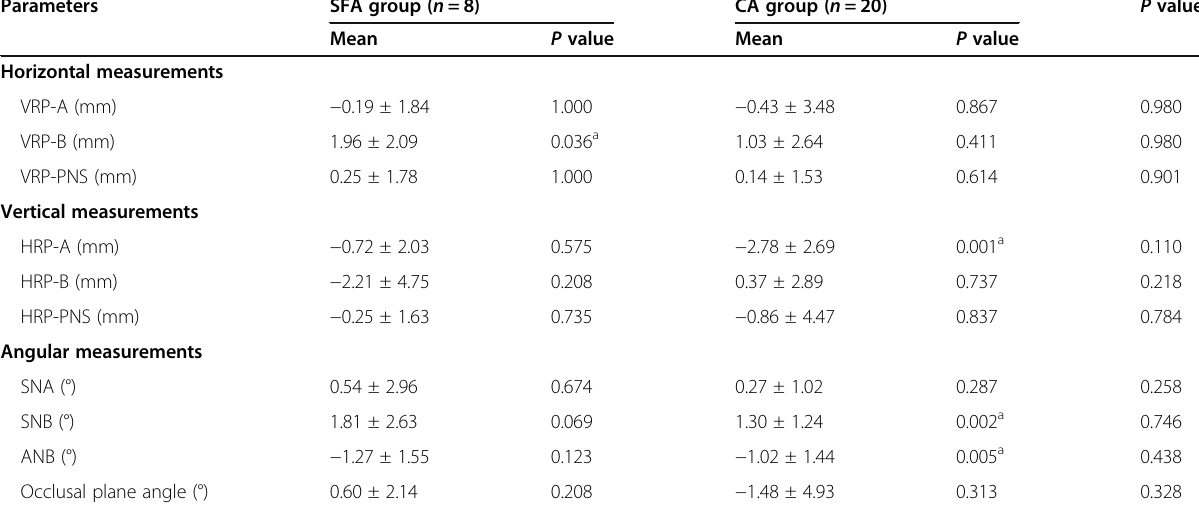
Table 4 Comparison of post-surgical change (T3-T2) on Experimental group and Control group Parameters SFA group ( n = 8) Horizontal measurements